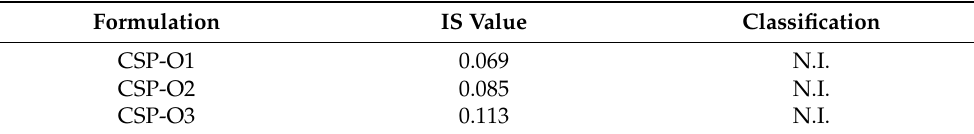
Table 6. Irritation Score (IS) of formulations tested with the HET-CAM test.